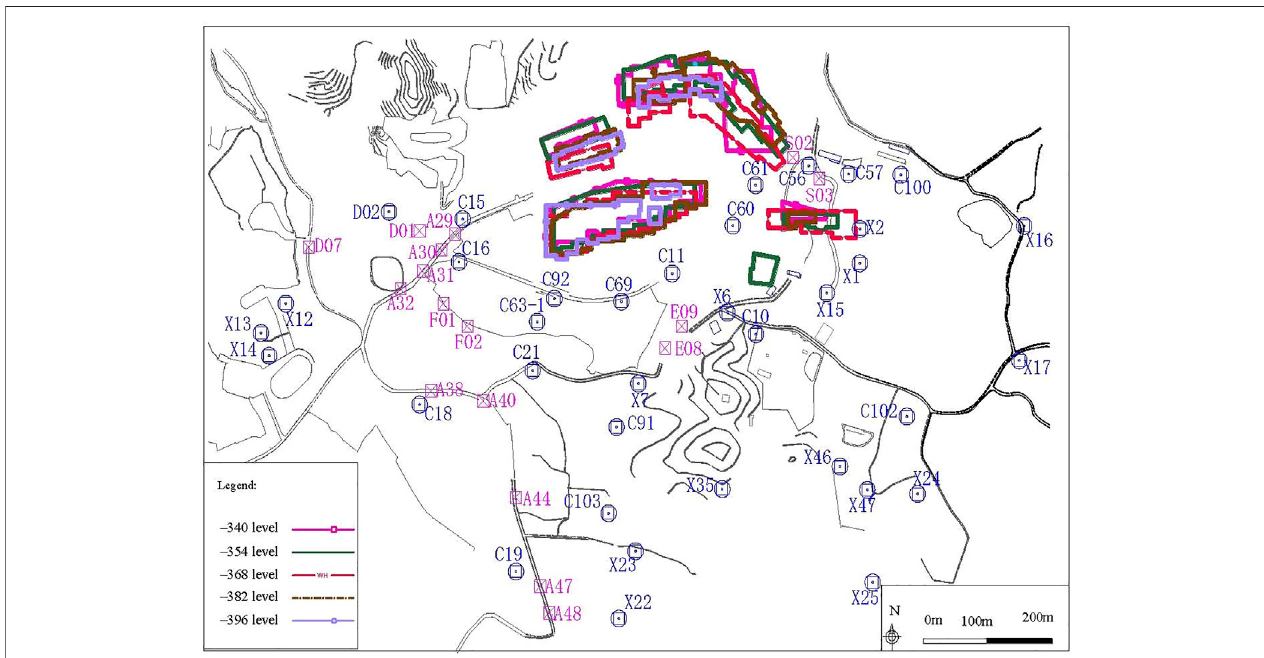
FIGURE 5 | Locations of some of the GPS (in blue) and level (in magenta) monitoring points used.